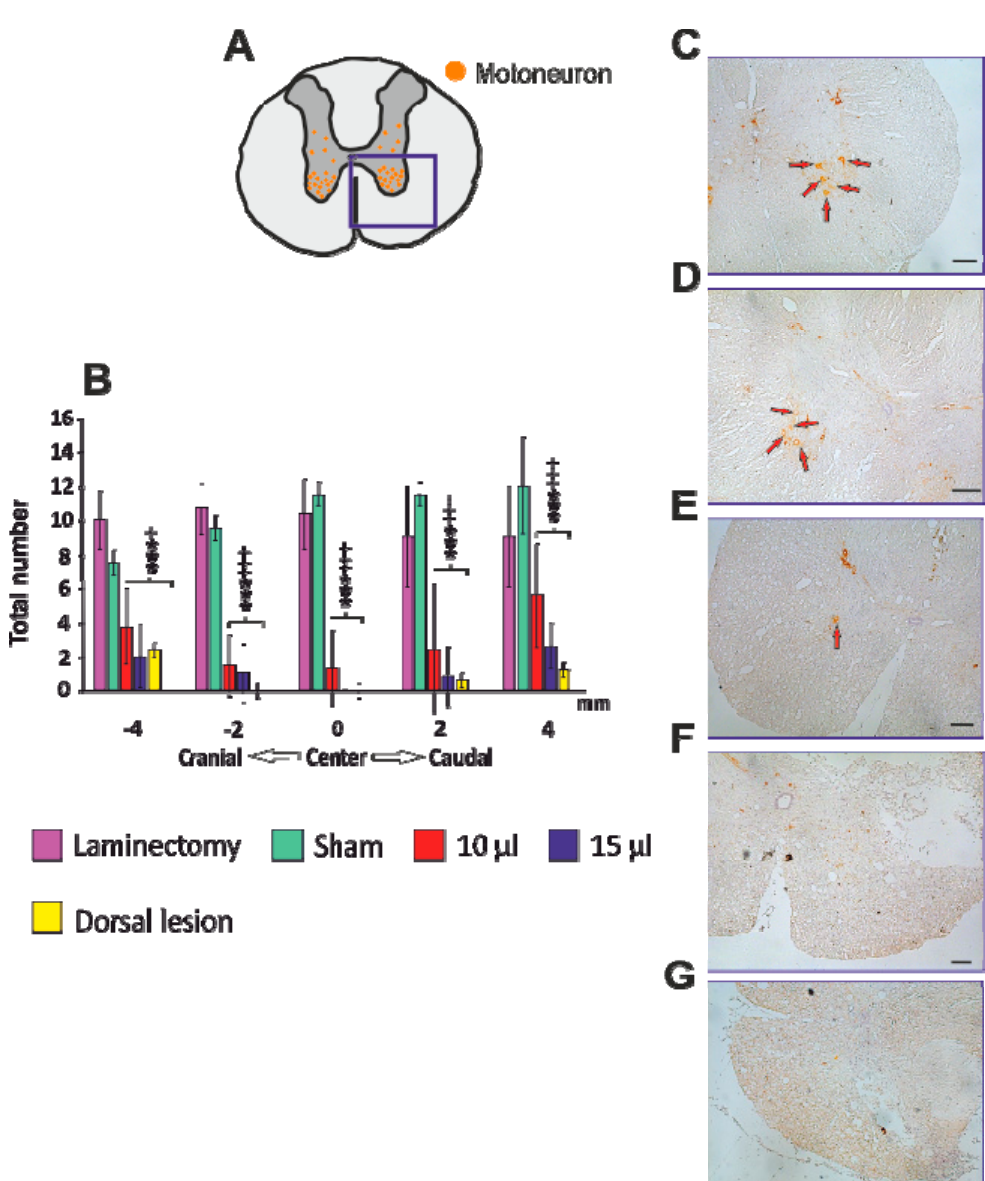
Figure 7. Immunohistochemical assessment of motoneurons. Total number of motoneurons localized in the ventral horn was counted on axial slices around the center of the lesion ( A ). Total number of motoneurons was significantly decreased in both ventrally injured groups and in dorsal SCI across the lesioned area ( B ). Representative immunohistochemical images with visible motoneurons (red arrows) from each group are shown ( C —laminectomy, D —sham, E —10 µ L, F —15 µ L, G—dorsal 15 µ L). For statistical details, see Table S8 in the Supplementaty Material. Scale bar: 200 µ m.Data are expressed as mean ± SEM. * p < 0.05 versus laminectomy; ** p < 0.01 versus laminectomy; *** p < 0.001 versus laminectomy; + p < 0.05 versus sham; ++ p < 0.01 versus sham; +++ p < 0.001 versus